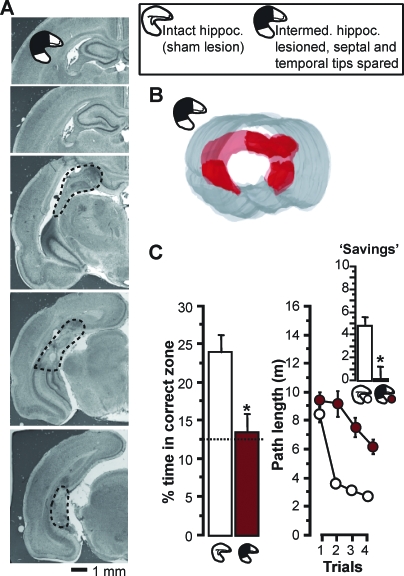
Experiment 5: Lesions to the Intermediate Hippocampus, Sparing the Temporal and Septal Tip, Abolish Performance Based on Rapid Place Learning(A) Cresyl-violet–stained coronal sections through the hippocampus of one exemplar brain with lesion to the intermediate hippocampus (arranged from most anterior, top left, to most posterior, bottom right; degenerated tissue without intact neurons outlined by stippled line).(B) Three-dimensional reconstruction of bilateral hippocampal volume in the same brain (compare Figure 1C for explanation and abbreviations). The residual hippocampal volume in the exemplar brain was 43%: 21% at the temporal and 22% at the septal tip. See Video S5 for an all-around view.(C) Performance on the rapid place-learning task in the watermaze (compare Figure 2A), as reflected by percentage time (% time) in correct zone on probes and path lengths on T1–T4, as well as path-length reductions from T1 to T2 (savings, inset graph) (all data: mean ± SEM), in rats with lesions to the intermediate hippocampus and in sham-operated rats. An asterisk (*) indicates significant group differences (p < 0.005). Sham-operated rats showed higher than chance search preference and a significant path-length reduction from trial 1 to 2 (t
11 > 5.23, p < 0.0003), but rats with lesions to the intermediate hippocampus did not (t
10 < 0.41).